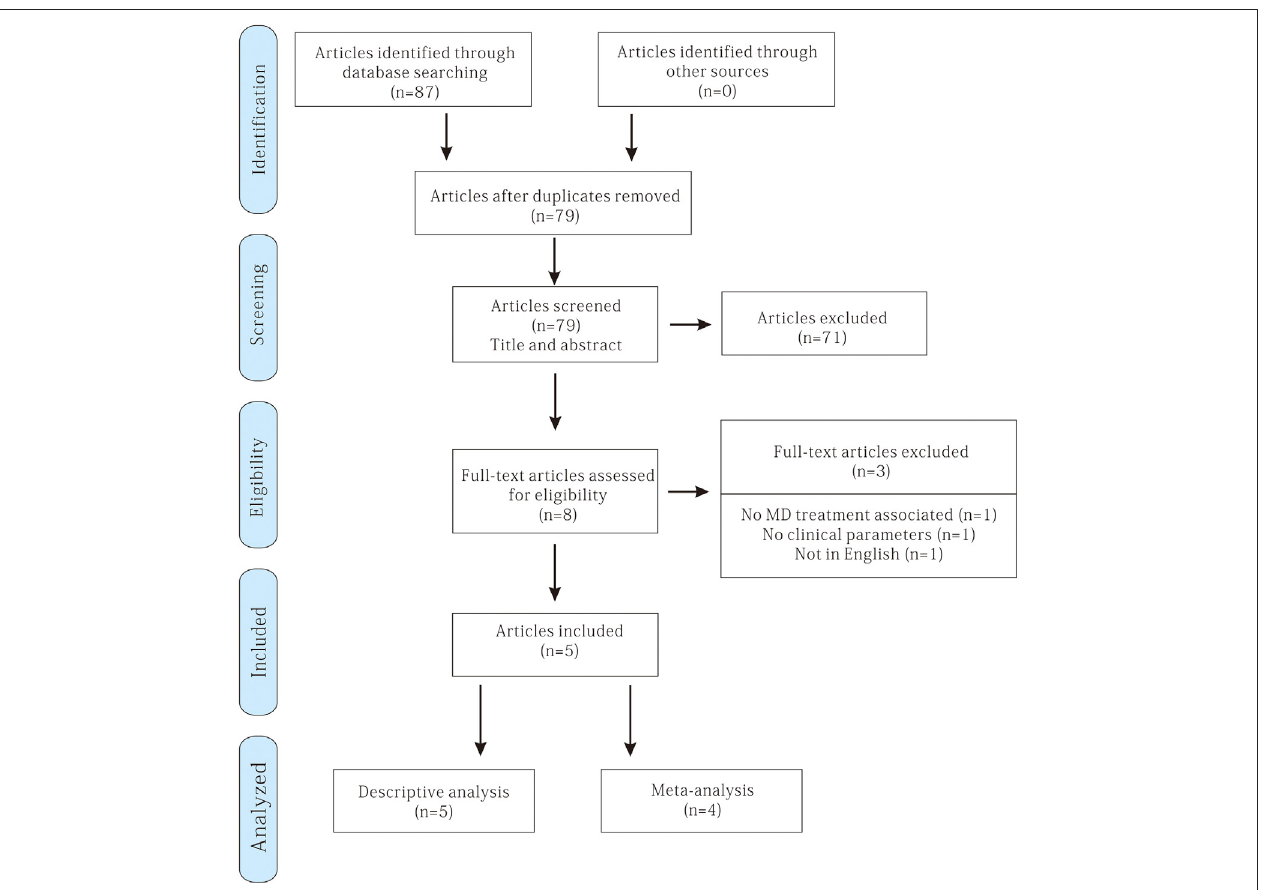
FIGURE 1 | Flow chart of the literature search and inclusion